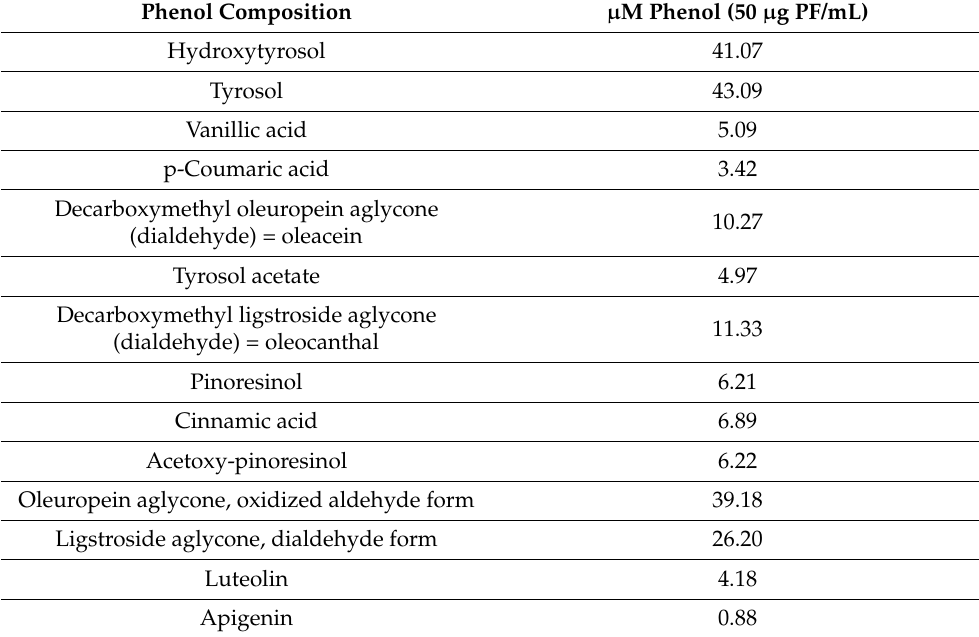
Table 2. Main composition of PF from VOO using